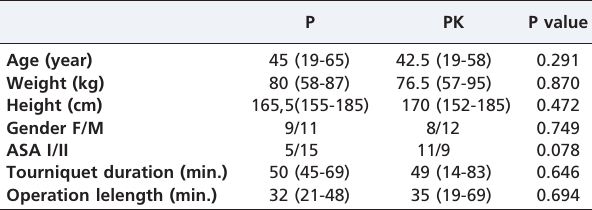
Table 2 - Demographic data, tourniquet duration, and operation length (median value, minimum-maximum).